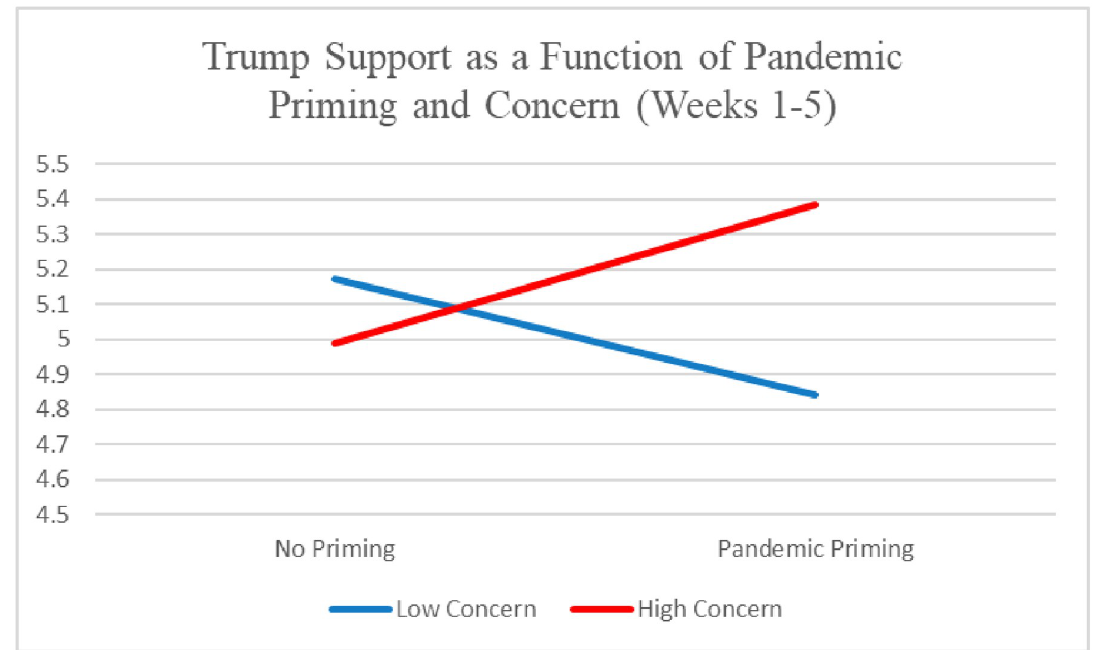
Fig 1. Republican Trump support as a function of pandemic priming and concern (weeks 1–5).